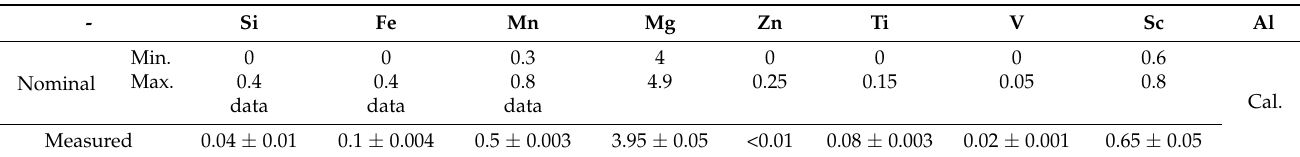
Table 1. Composition of the manufactured specimens measured via spark-emission spectroscopy along with the nominal values of Scalmalloy ® .